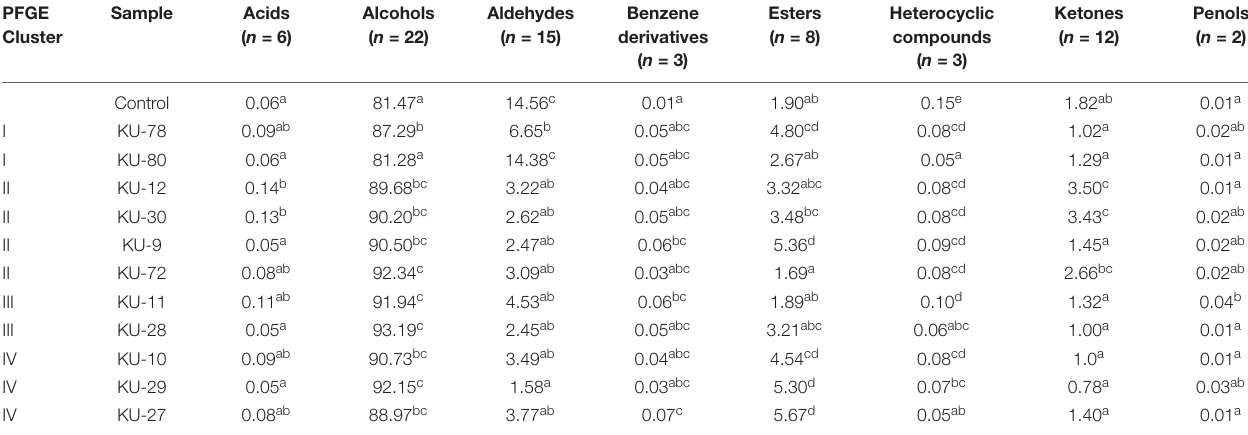
The relative percentage of relative peak area of each chemical class of samples, (n) refers to the number of volatile compounds in each class. Values in each classification marked by different lowercase letters are significantly different using one-way ANOVA with Duncan’s test ( ≥ 95% confidence, n = 2). Clusters are based on chromosome polymorphism between the stains as determined by PFGE.